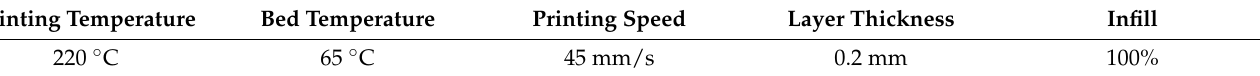
Table 3. FDM printing parameters.